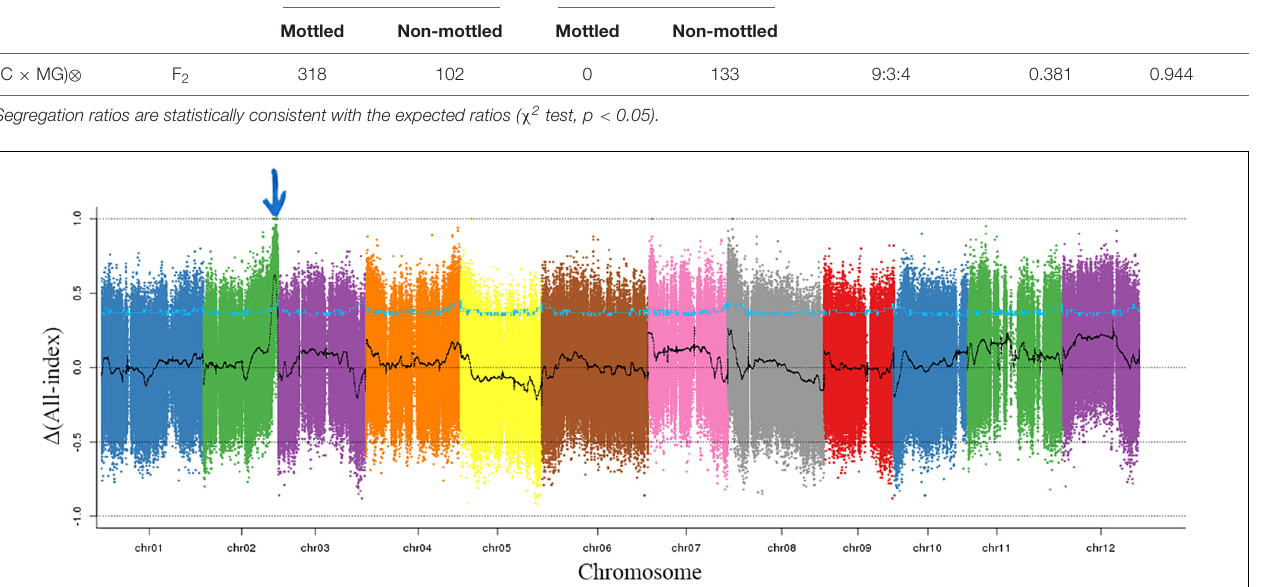
a dark green mottled rind line HPG and a dark green non-mottled rind line MR-5 ( Supplementary Figure 1 ). And the segregation ratio fits a 1:1 ratio as determined by a Chi-square test ( χ 2 =